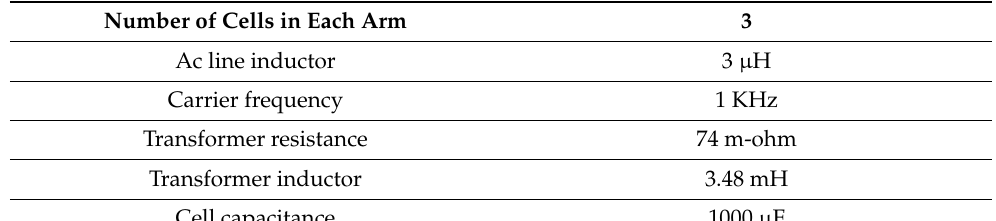
Table 2. Simulated converter parameters.